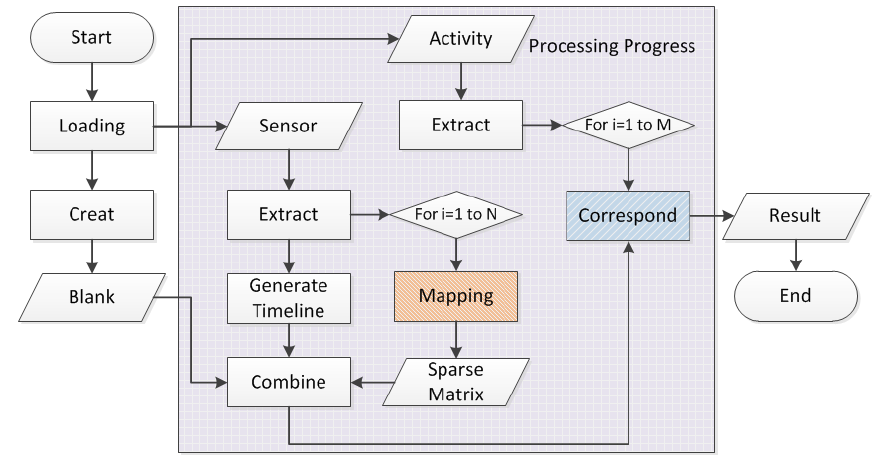
Figure 2. Abstract flowchart of the mapping function.